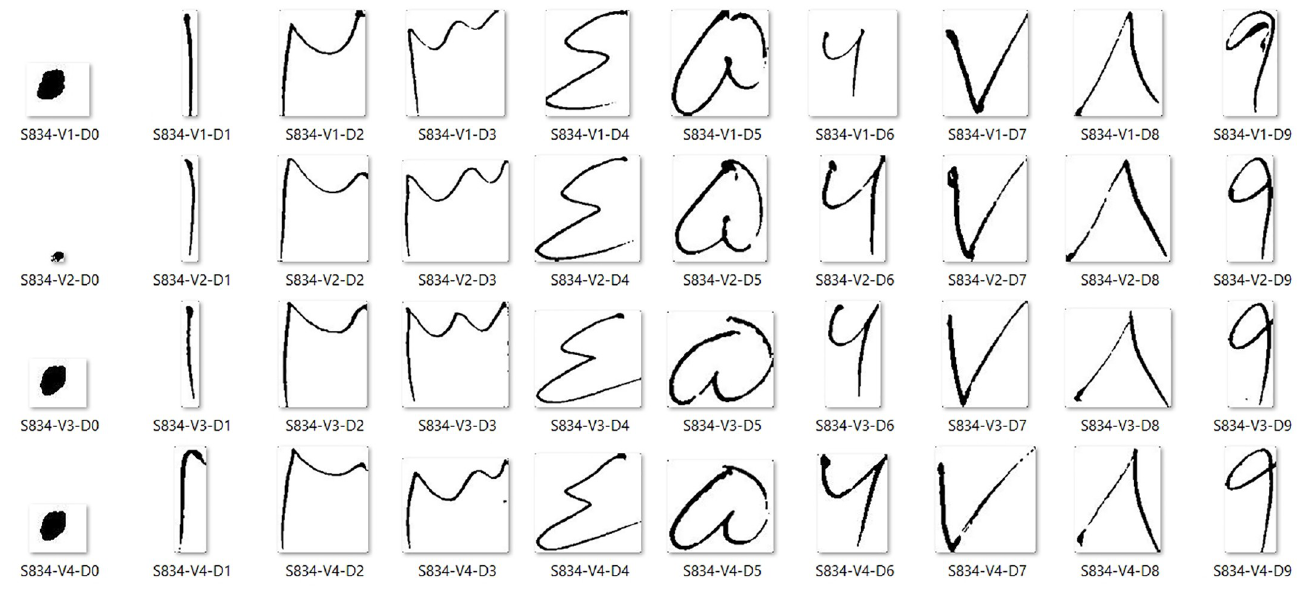
Fig 2. Images in the folder, with name